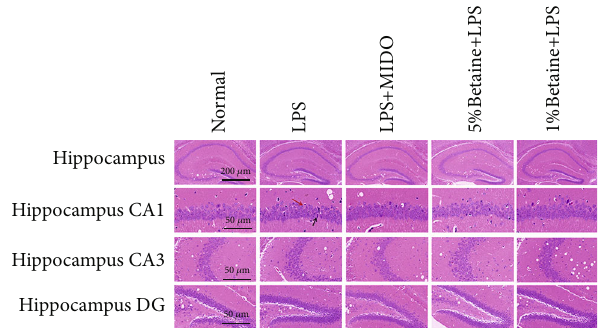
Figure 3: HE staining to observe the morphological changes of LPS-induced mice hippocampal CA1, CA3, and DG regions, n = 6 . Red arrows indicate the irregular arrangement of neurons with enlarged pericellular spaces, black arrows indicate the neuronal pyknosis and the deepened